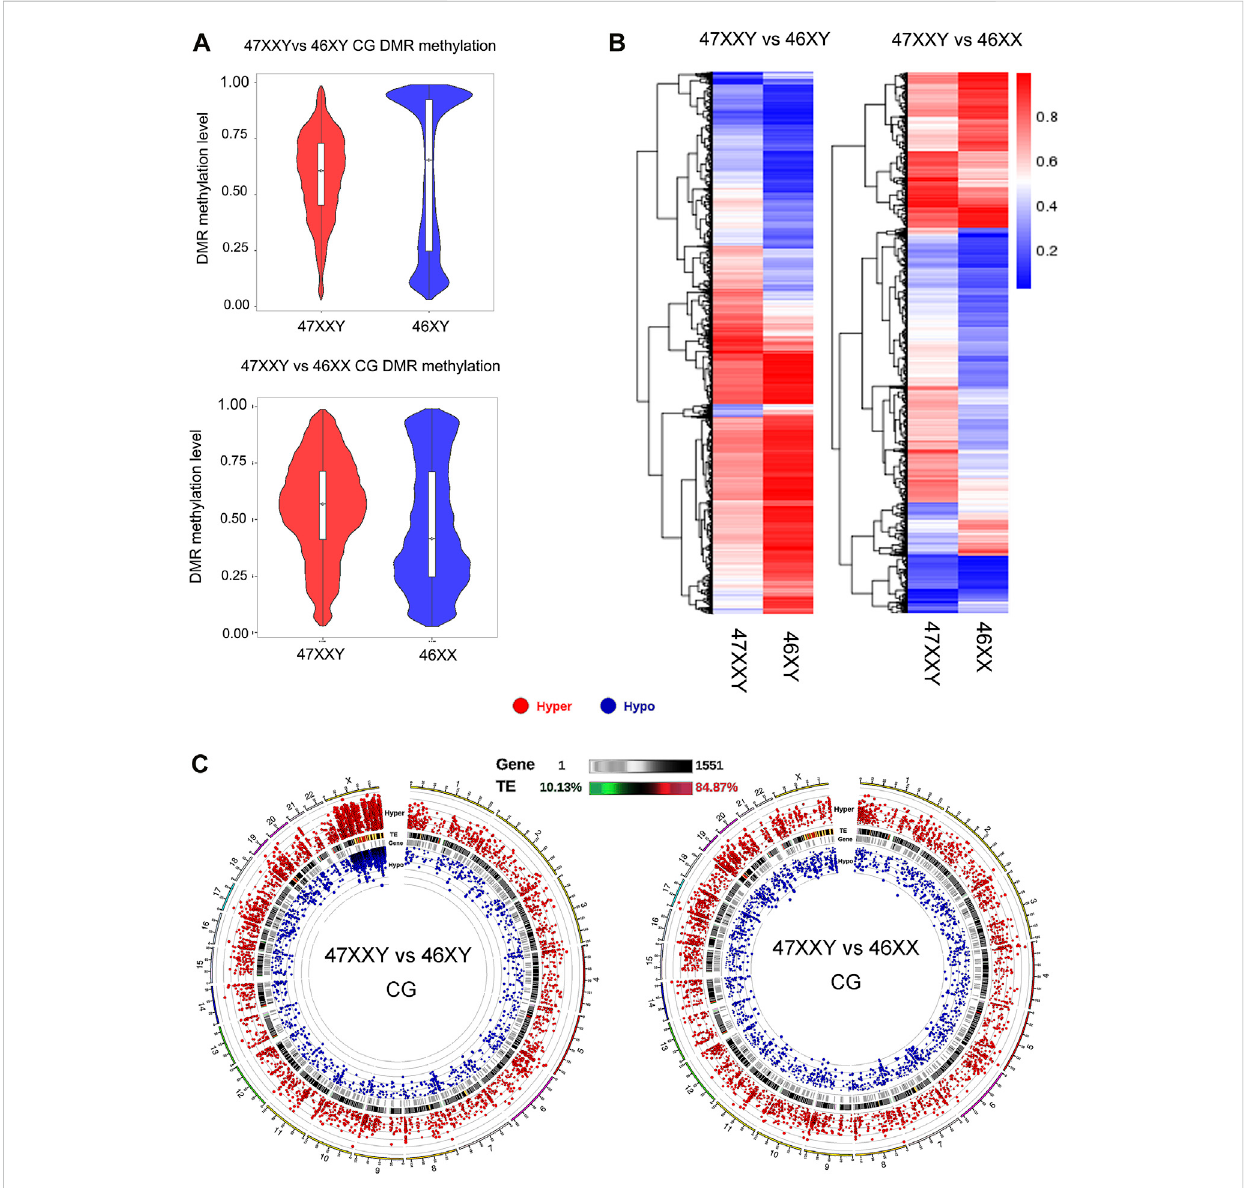
FIGURE 2 Comparison analysis in CG DMR genes in two groups (47XXY vs. 46XY and 47XXY vs. 46XX) (A) The violin map of horizontal distribution in CG DMR methylation (47XXY vs. 46XY and 47XXY vs. 46XX). The X-coordinaterepresents thecomparison group, and the Y-coordinate represents the methylation levelvalue.ThedistributionofDMRmethylationlevelisshownintheformofviolinplot(boxplotinsideandthequantitydistributionunderthismethylation level on the fl ank). (B) The heatmap of clustered CG DMR methylation level. The horizontal axis represents the comparison group, the vertical axis represents themethylation level value clustering effect, and theblue to redrepresents themethylation level fromlow to high. (C) Circos mapof CGDMR methylation genes in two comparison (47XXY vs. 46XY and 47XXY vs. 46XX). From outside to inside: (1) Hyper DMR statistic log 5 (|areaStat|) ; The higher the outward dot is, the more signi fi cant the position difference is. The red circle represents hyper CG DMR. (2) TE, and the heat map of the proportion of repeat original. (3) Gene density heat map. (4) Hypo DMR statistic log 5 (|areaStat|)